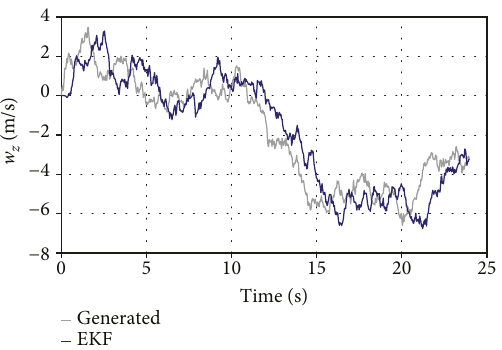
Figure 15: Error of estimation of ICP-89 pitch angle.